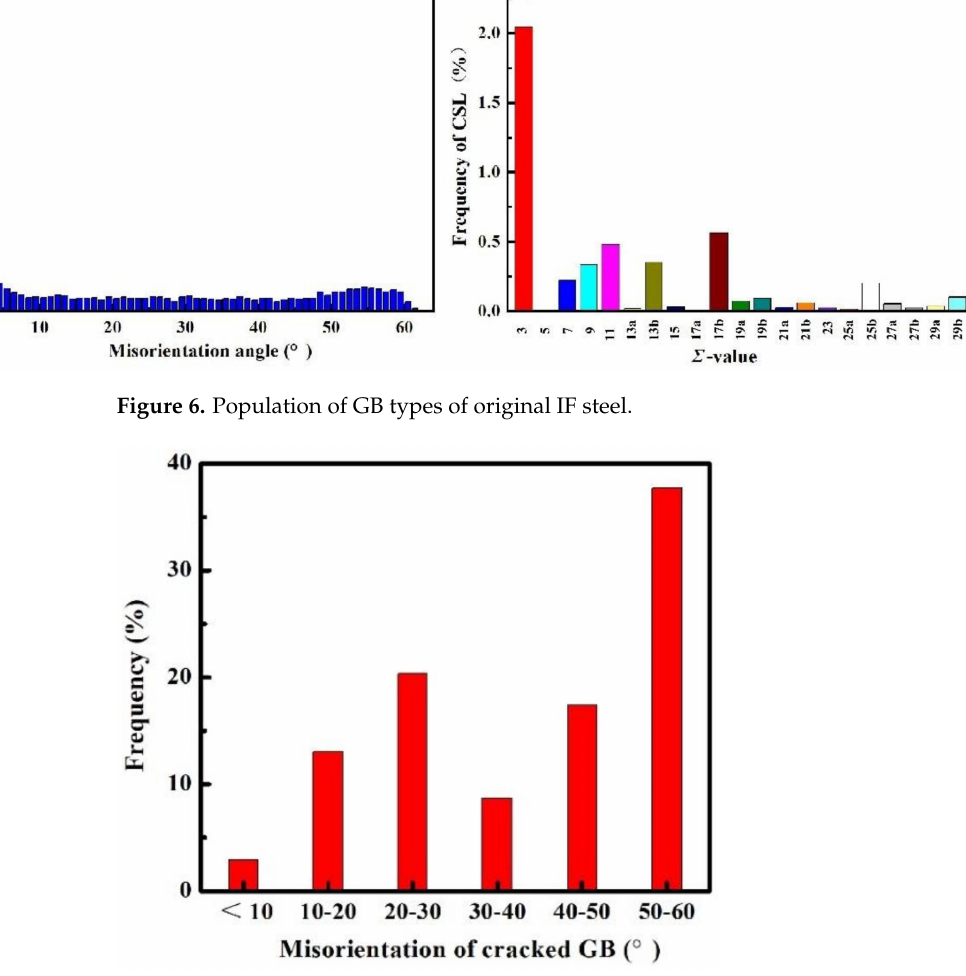
Figure 7. Ratio of the crack orientation difference in the hydrogen-charged specimens.